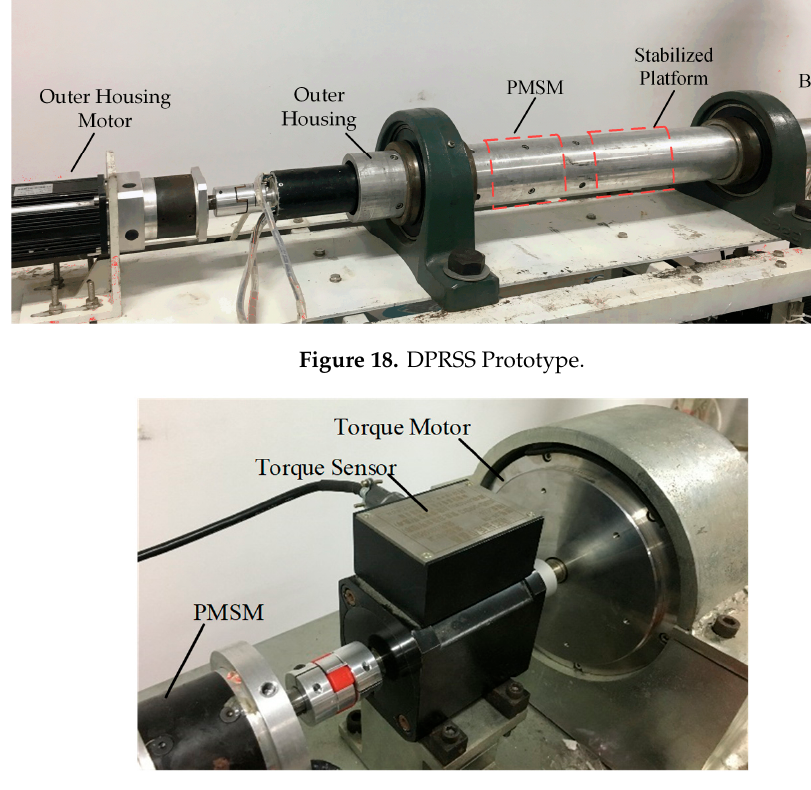
Figure 18. DPRSS Prototype.